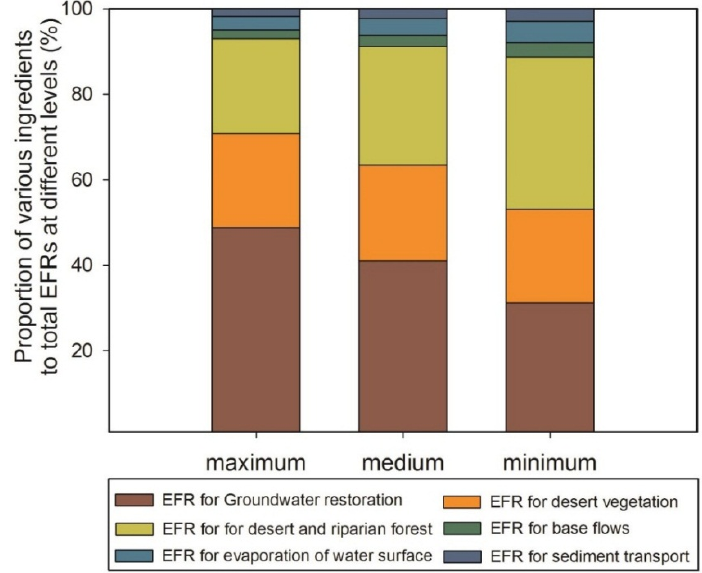
Figure 6. Proportion of various ingredients to the total EFRs for multiple ecosystem functions at different levels (Maximum, Medium, and Minimum) in Qira